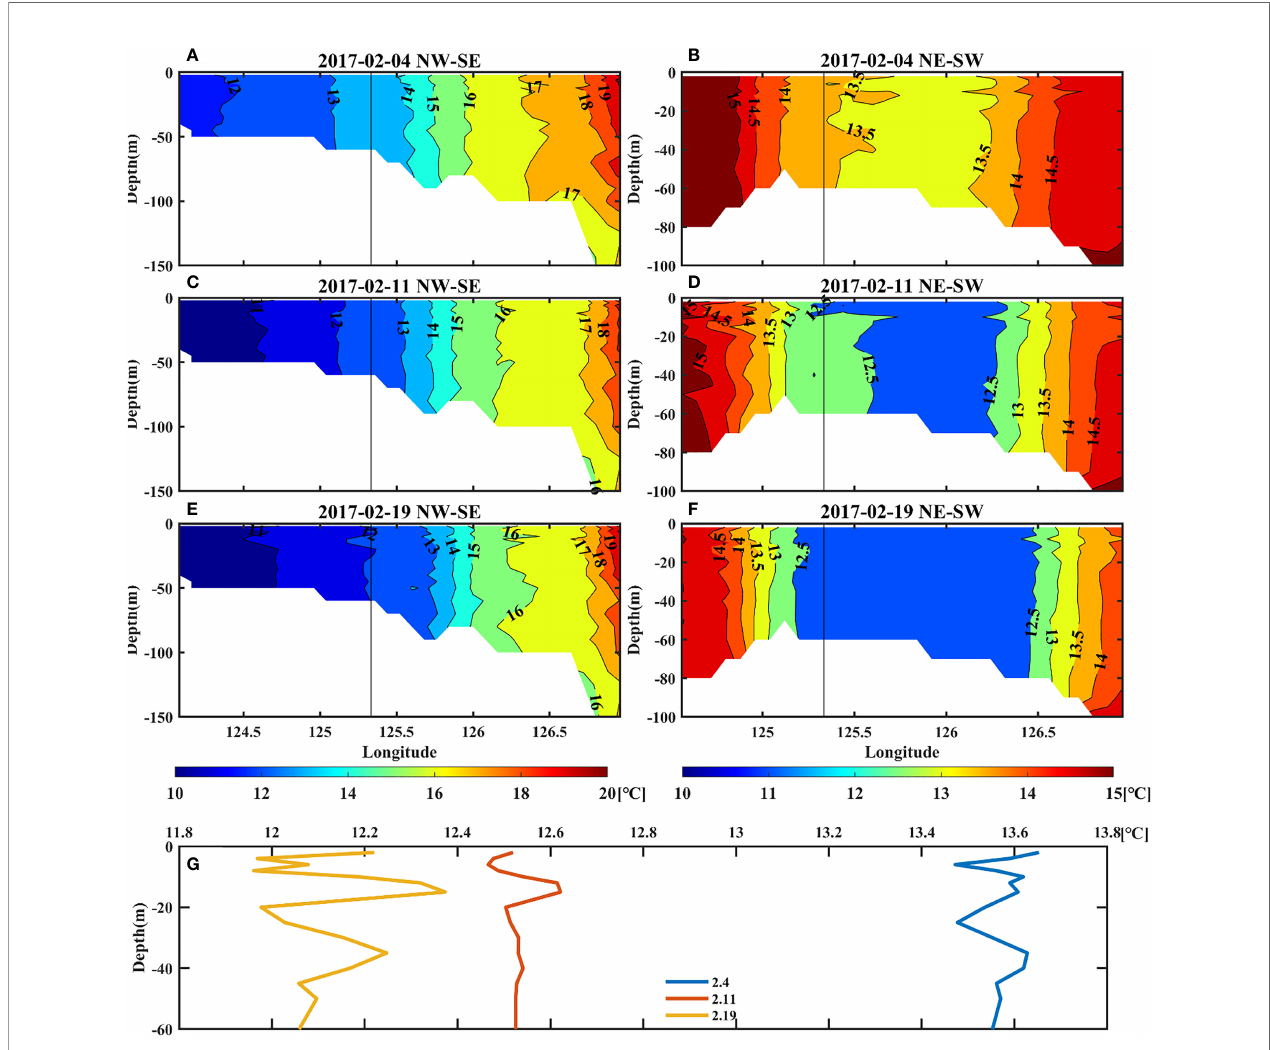
FIGURE 7 | Upper left panels: the vertical temperature pro fi le of the northwest-southeast direction (A, C, E) . Upper right panels: the vertical temperature pro fi le of the northeast-southwest direction (B, D, F) . Bottom panels: the vertical variation of temperature at the target site (G) . The temperature data were obtained from the regional